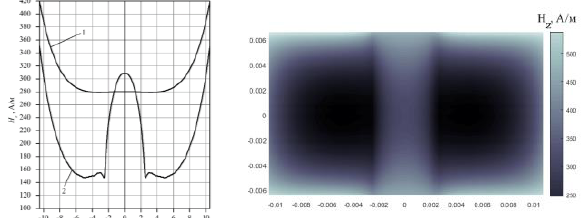
Fig.4. Distribution of strength magnetic field in the area above the block (a): block without weld (1); block with weld (2); topogram of the magnetic field in the region over a block with a welded seam (b).